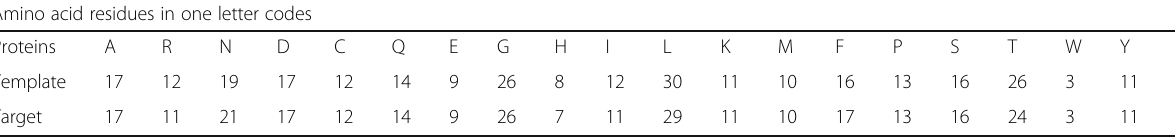
Table 3 Amino acid composition table for both template and target protein Amino acid residues in one letter codes Proteins